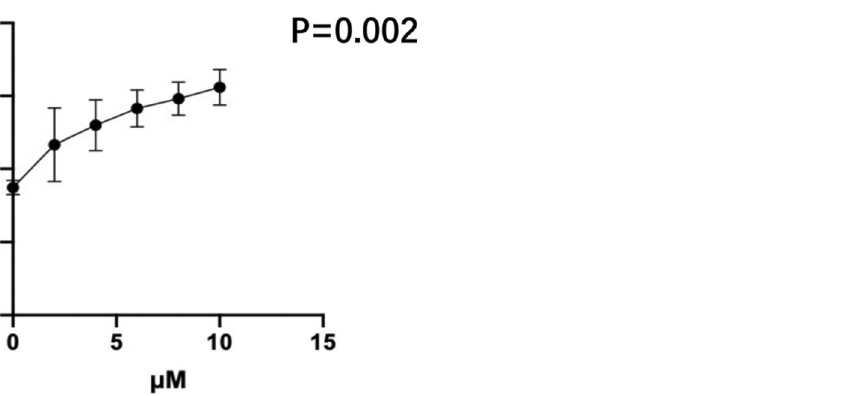
Figure 5. Effects of different concentrations of RSL3 on the rate of LDH release from BeWo cells (biological replicates number: 1). With the gradual increase of the ferroptosis inducer RSL3 concentration, the mortality rate of BeWo cells increased significantly. Differences among groups were compared by single factor analysis of variance